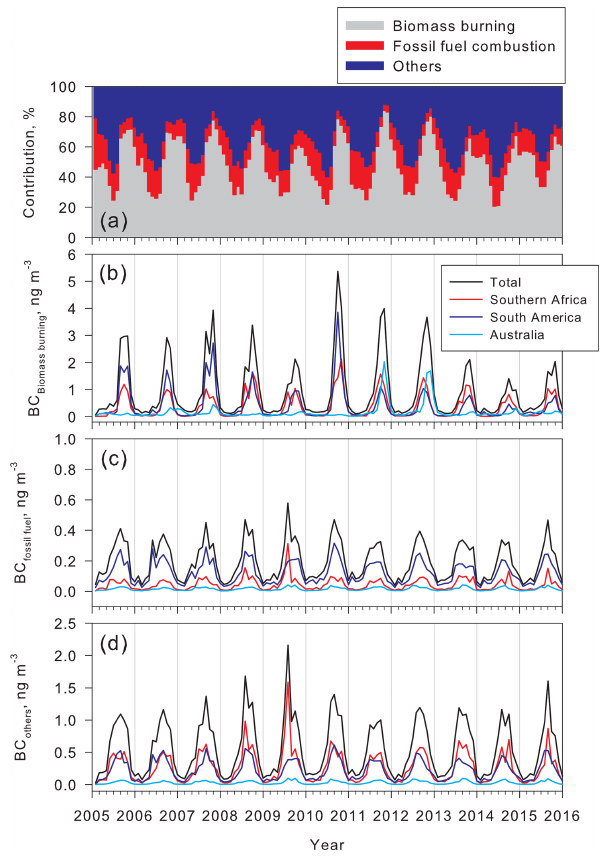
Figure 9. Seasonal features of (a) contribution of potential origins of mBC at Syowa Station, (b) the concentrations of mBC released from biomass burning in major PSA, (c) the concentrations of mBC released from combustion of fossil fuels in major PSA, and (d) the concentrations of mBC released from the others in major